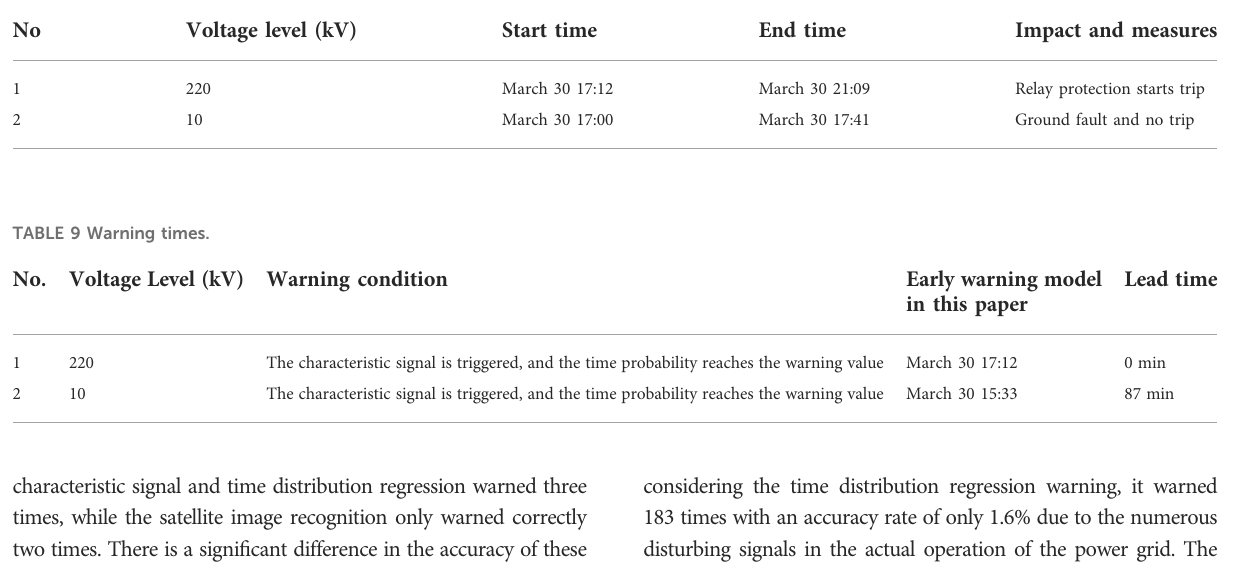
TABLE 8 Records of wild fi res affecting power grid in Liangshan district in March 2020.